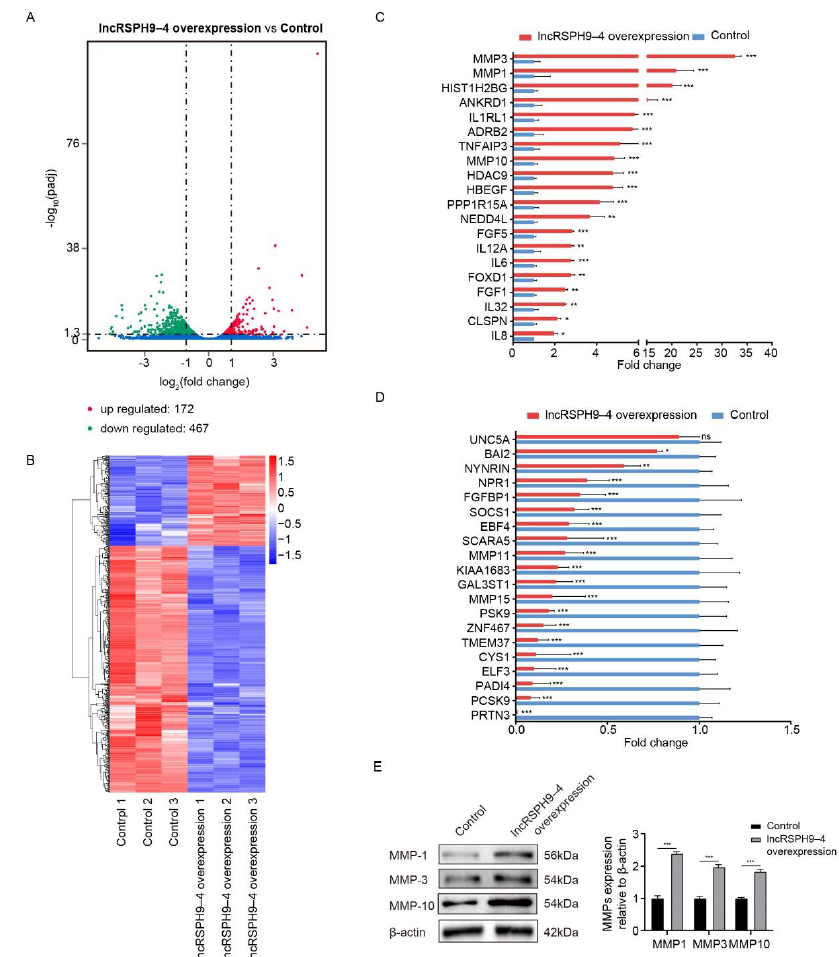
Figure 3. The mRNA transcription profiles in lncRSPH9-4 overexpressed hBMECs. ( A ) Volcano plot showing the differ- entially expressed mRNAs in lncRSPH9-4 overexpressed hBMECs compared with control cells. The red and green plots represent the significantly up-regulated and down-regulated mRNAs, respectively. ( B ) The heatmap showing the unsu- pervised clustering of significantly expressed mRNAs in hBMECs with or without lncRSPH9-4 overexpression. ( C,D ) qPCR validation of the up-regulated ( C ) or down-regulated ( D ) mRNAs in hBMECs in response to lncRSPH9-4 overex- pression. GAPDH was used as the reference control. * p < 0.05, ** p < 0.01 and *** p < 0.001 by one-way ANOVA analysis. ( E ) Western blotting showed the significant up-regulation of the MMPs family members MMP1, MMP3 and MMP10. The β -actin was used as the loading control and densitometry was performed to analyze differences.